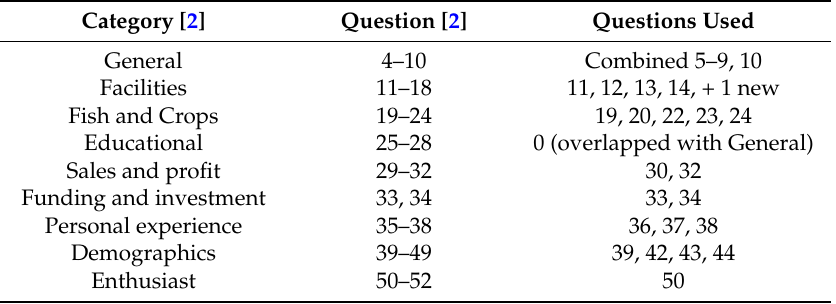
Table 1. List of categories and questions used in the original survey by Love et al. [2] and the questions used in the current survey, which were more directed towards research and commercial